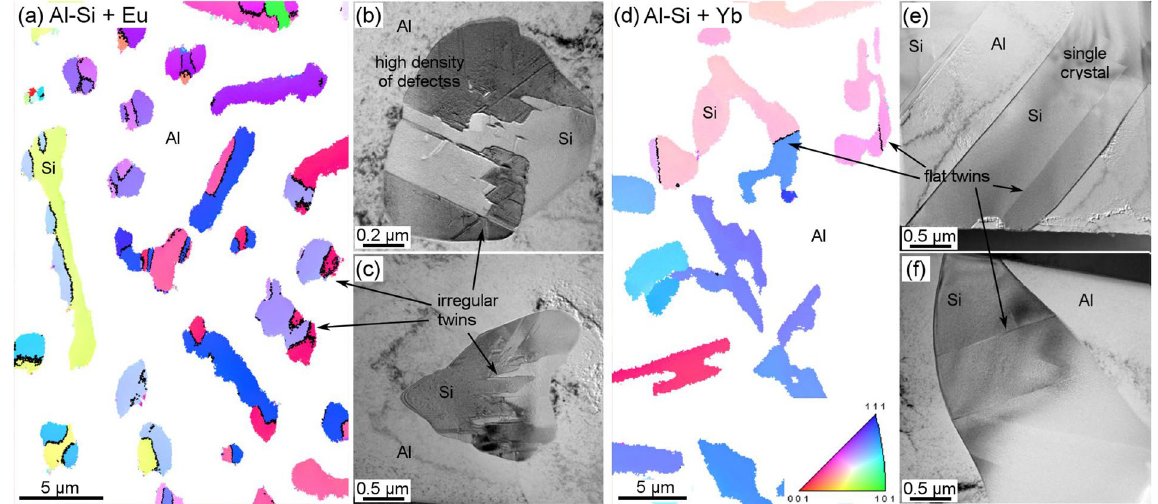
Figure 2. Inverse pole figures of EBSD maps in Al-5 wt.%Si alloys modified by: ( a ) Eu (step size 30 nm) and ( d ) Yb (step size 90 nm). Black lines show twin boundaries in Si. White areas correspond to the Al matrix which was filtered out for clarity. TEM images show high density of crystallographic defects in the Si structure of the Eu modified alloy ( b , c ); and only flat twin planes across the Si crystal in the alloy with Yb addition ( e , f